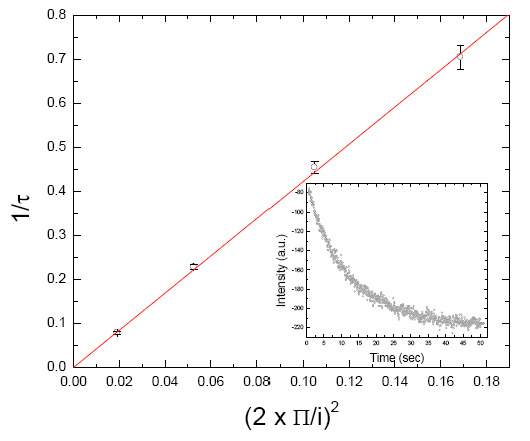
Figure 5. A τ −1 versus i −1 plot for the diffusion of MexA protein inside a sponge